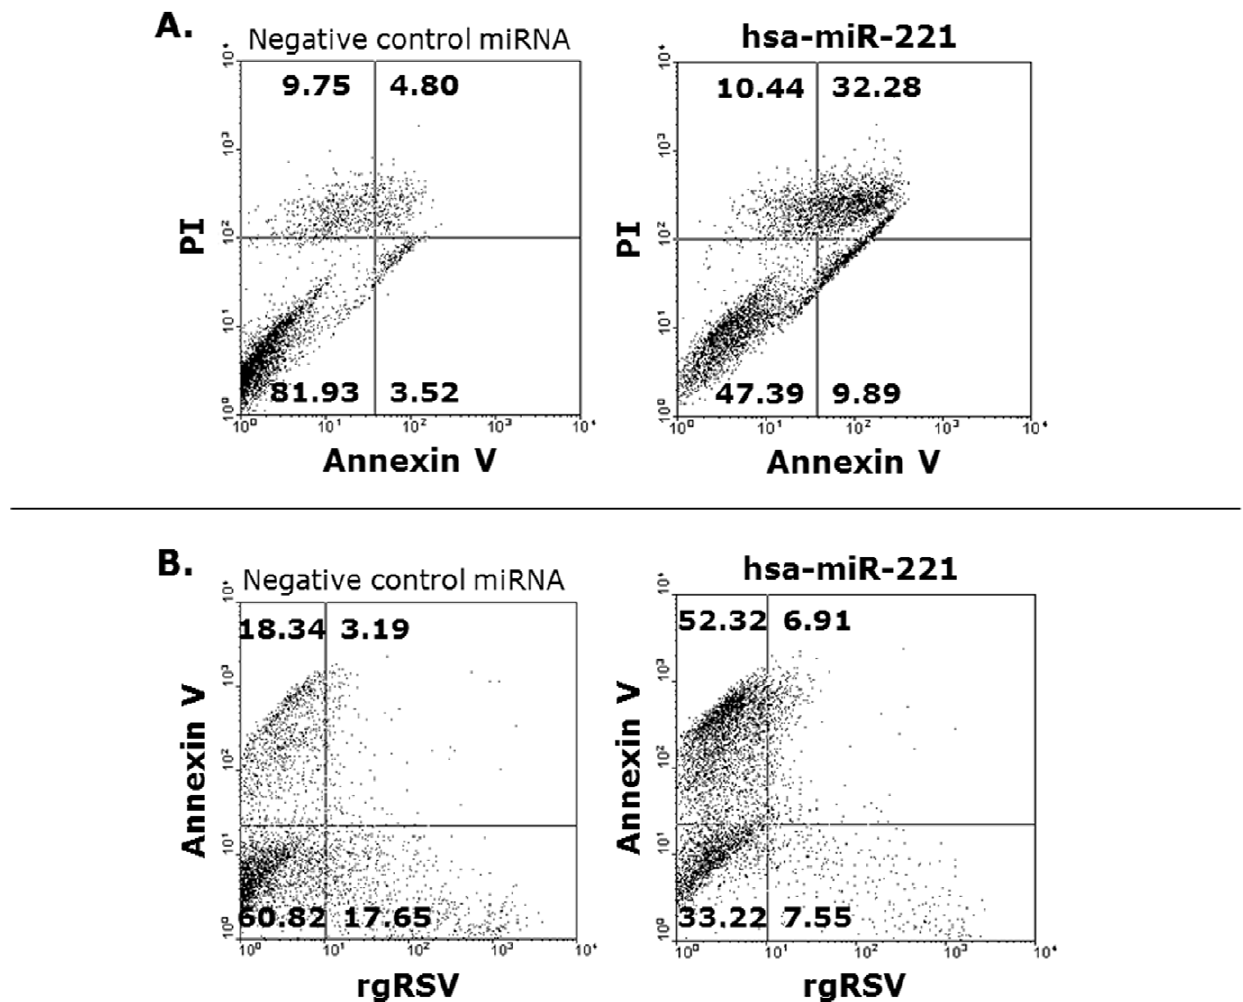
Figure 4. Programmed death of RSV-infected cells. (A) Non-infected cells transfected with hsa-miR-221 were more prone to apoptosis detected by annexin V staining compared to cells transfected with the negative control miRNA. In contrast, hsa-miR-221 transfection did not change the proportion of necrotic cells detected by propidium iodide (PI) staining. (B) After infection with rgRSV, approximately 3 times more hsa-miR-221- transfected cells became apoptotic compared to cells transfected with negative control miRNA. Left upper quadrant=necrotic cells; left lower quadrant=viable cells; right lower quadrant=apoptotic cells; right upper quadrant=late apoptotic cells in necrotic state.